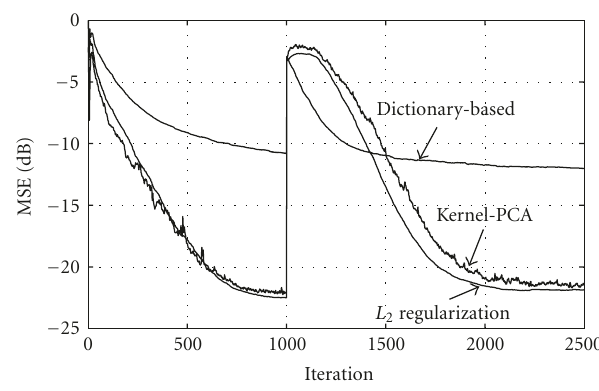
[ n ] obtained by adaptive iden- r